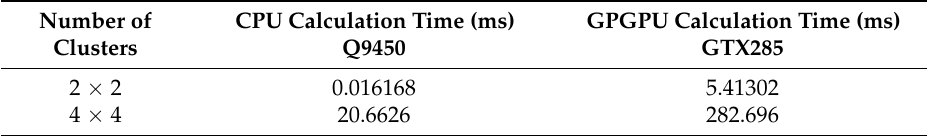
Table 3. Comparison of calculation time after selecting CUDA.